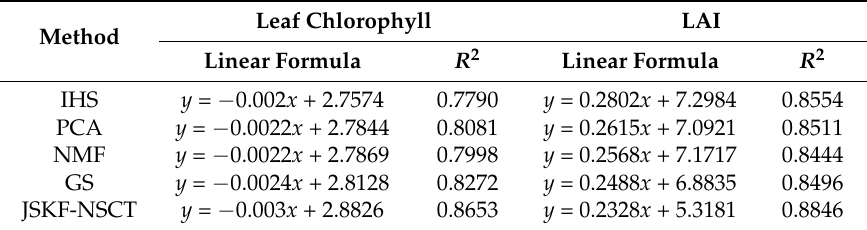
Table 10. Results of comparison at Stage I.